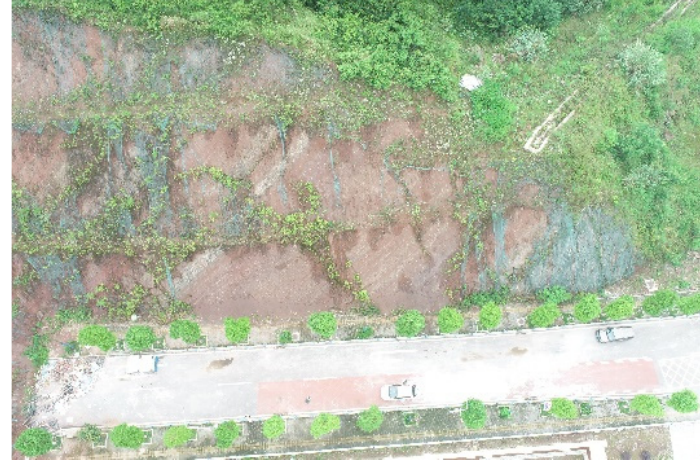
Figure 14. UAV image of Lihua landslide.